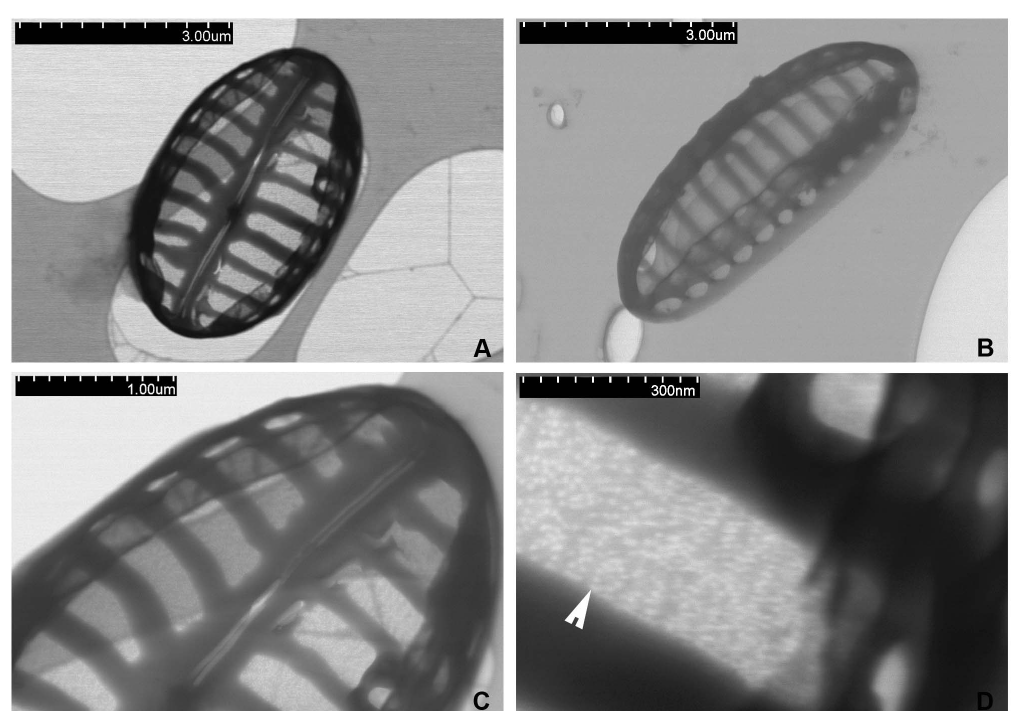
Figure 5. Biremis panamae sp. nov., TEM. A. A whole valve in valve view. B. A whole specimen observed from the valve interior. C, D. Close ups of a specimen illustrated in Fig. 5A; note the finely porous areolae occlusions, arrowhead in Fig.